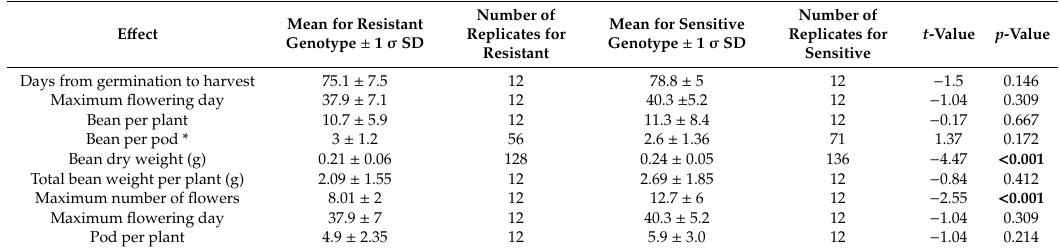
Table 1. E ff ect of ambient ozone level on resistant and sensitive genotypes of Phaseolus vulgaris . Standard deviations, t -values, and the significance levels are also shown. * include pod with zero number of beans. Bolded p-value means statistically significance. E ff ect